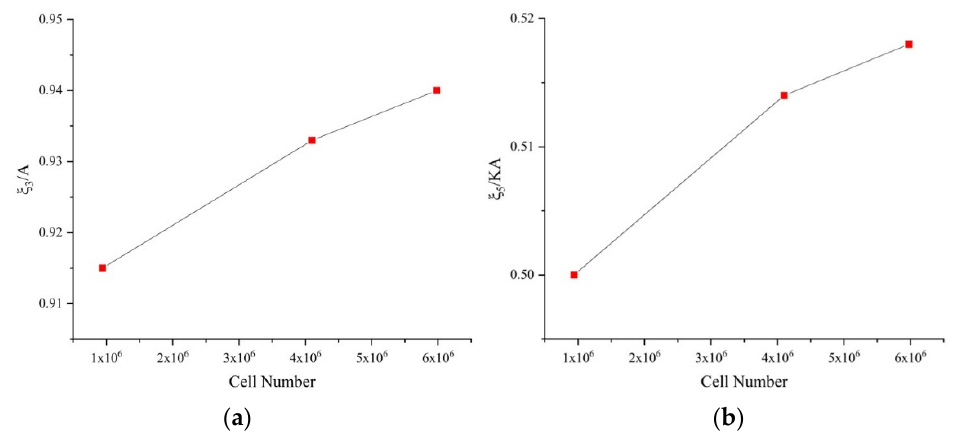
Figure 15. Mesh convergence test. ( a ) Heave. ( b ) Pitch.